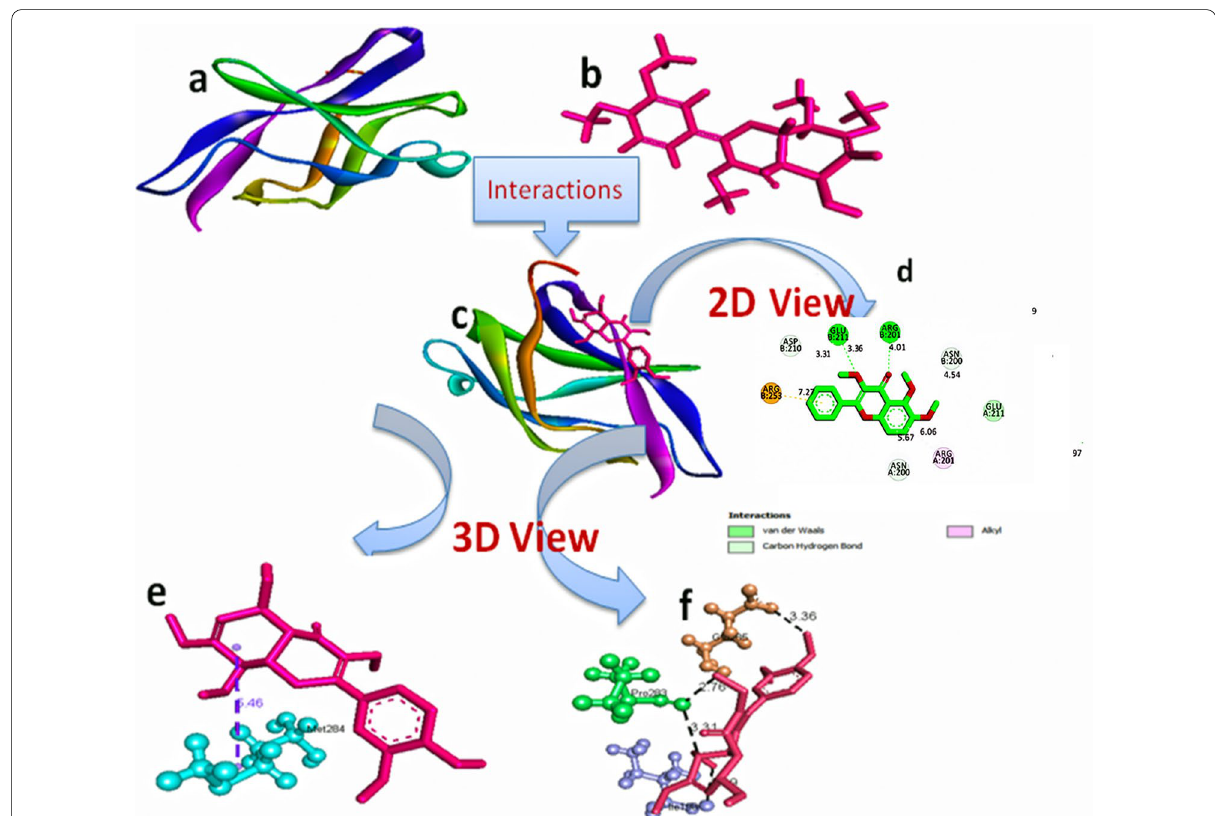
Fig. 1 Autodock of 1BFT (NF-kB p50) with TMF a The three-dimensional structural representation of predicted NF-kB p50. b The three-dimensional structure of TMF. c The molecular representations of Docked complexes. d 2D Interactions of ligand and Protein. e Interaction of ligand with NF-kB p50 at Methionine 284 via alkyl bond. f Interaction of ligand with NF-kB p50 at Iso-leucine 196, Proline 283, and Glutamic acid